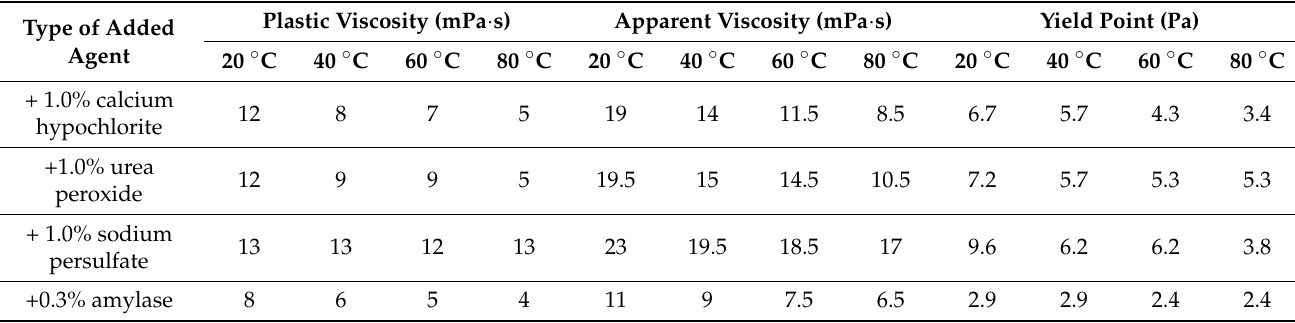
Table 2. The rheological parameters of potassium-polymer drilling mud A with thinning additives at various tempera- ture